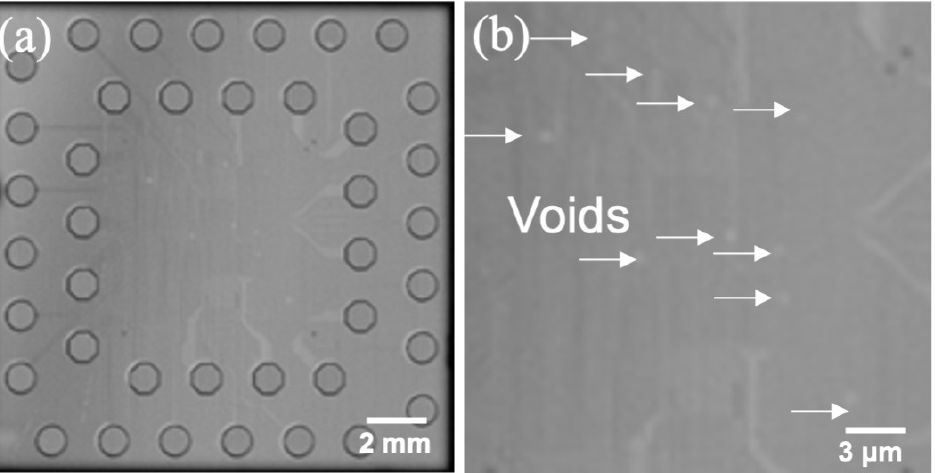
Figure 5. ( a ) CSAM results for bonded dies showing more than 95% areas are well bonded. ( b ) En- larged image of bonded area with small voids indicated by pointed arrows.